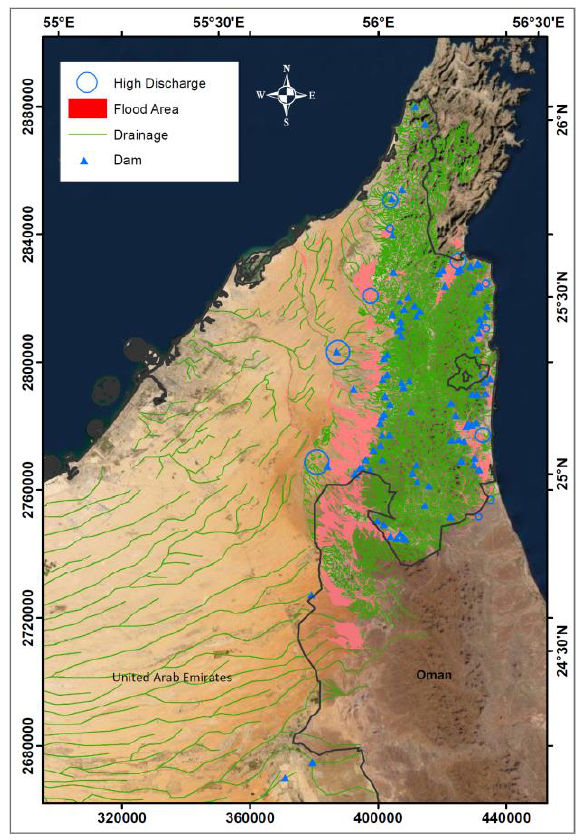
Figure 13. Drainage map and existing dams in the